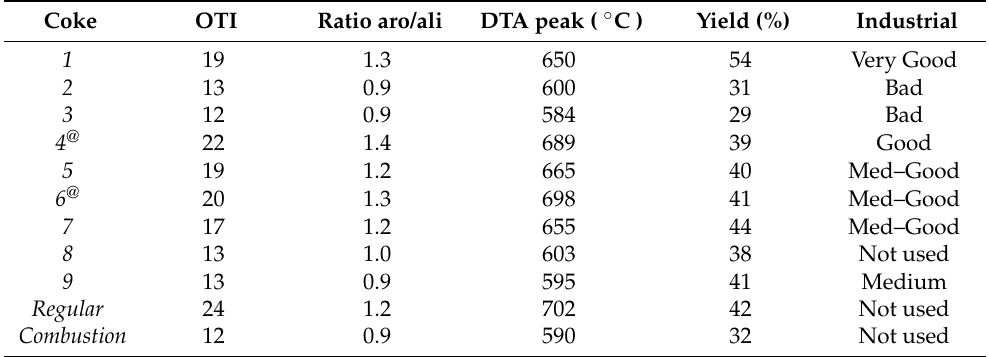
Table 3. Proposed additional characterisation of coke used for the manufacture of SiC and yield at both laboratory and industrial levels. OTI is the Optical Texture Index